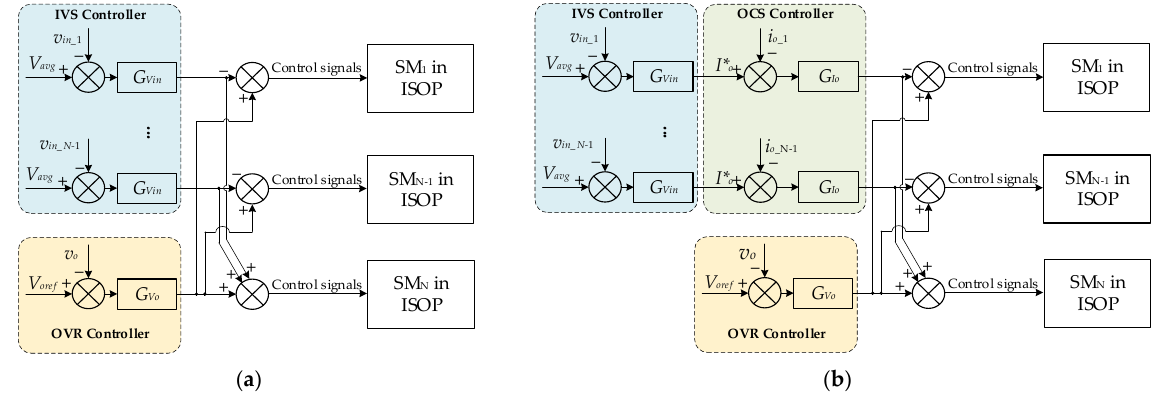
Figure 4. The master–slave control strategies for ISOP: ( a ) OVR–IVS control block and ( b ) OVR–IVS–OCS control block.